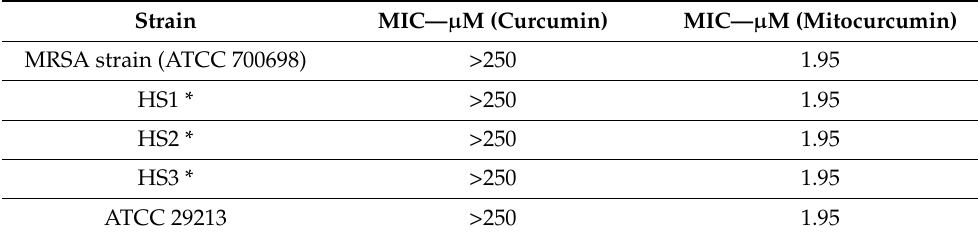
Table 2. Minimal inhibitory concentrations of curcumin and mitocurcumin for different MRSA. Strain MIC— µ M (Curcumin) MIC— µ M (Mitocurcumin)